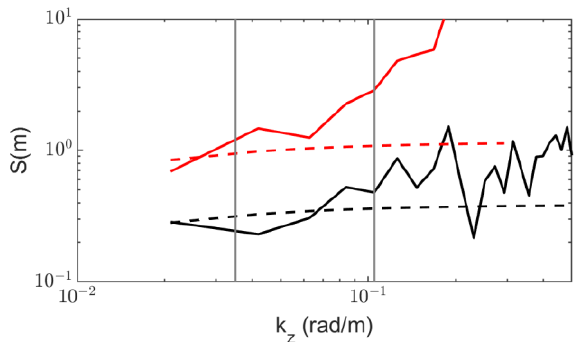
Figure A6. Estimation of the uncertainty in 𝑅 𝜔 . The red lines represent shear spectra while black lines represent strain spectra. Solid lines stand for measured spectra from CTD/LADCP cast 35 and dashed lines stand for spectra from the GM model. Table A1. Mean uncertainties (and their standard deviations) of N, Rw, Ea and log 10 ( ε).